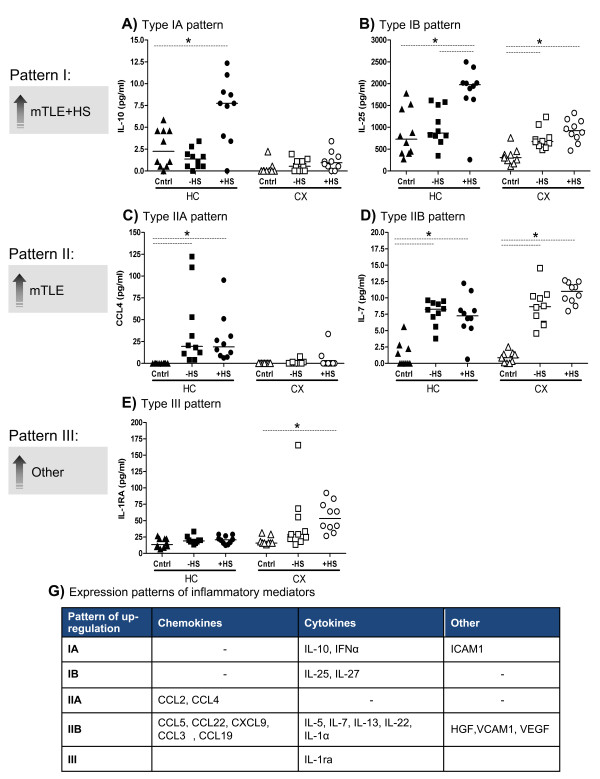
HC and CX expression patterns of inflammatory proteins in mTLE. Scatter plots of protein levels per individual patient, per group. Horizontal lines represent the median expression level of the group. Post-hoc analysis of the data revealed three expression patterns among the patient groups. We classified them as Type I to III (I: A and B, II: C and D, III: E). Additionally, different patterns were detected depending on the type of tissue, hence we classified an up-regulation in HC only as A (A and C) and an up-regulation in both HC and CX as B (B and D). * indicates significant difference. All significantly changed proteins showed one of these three expression patterns (G) (see Figure 2)